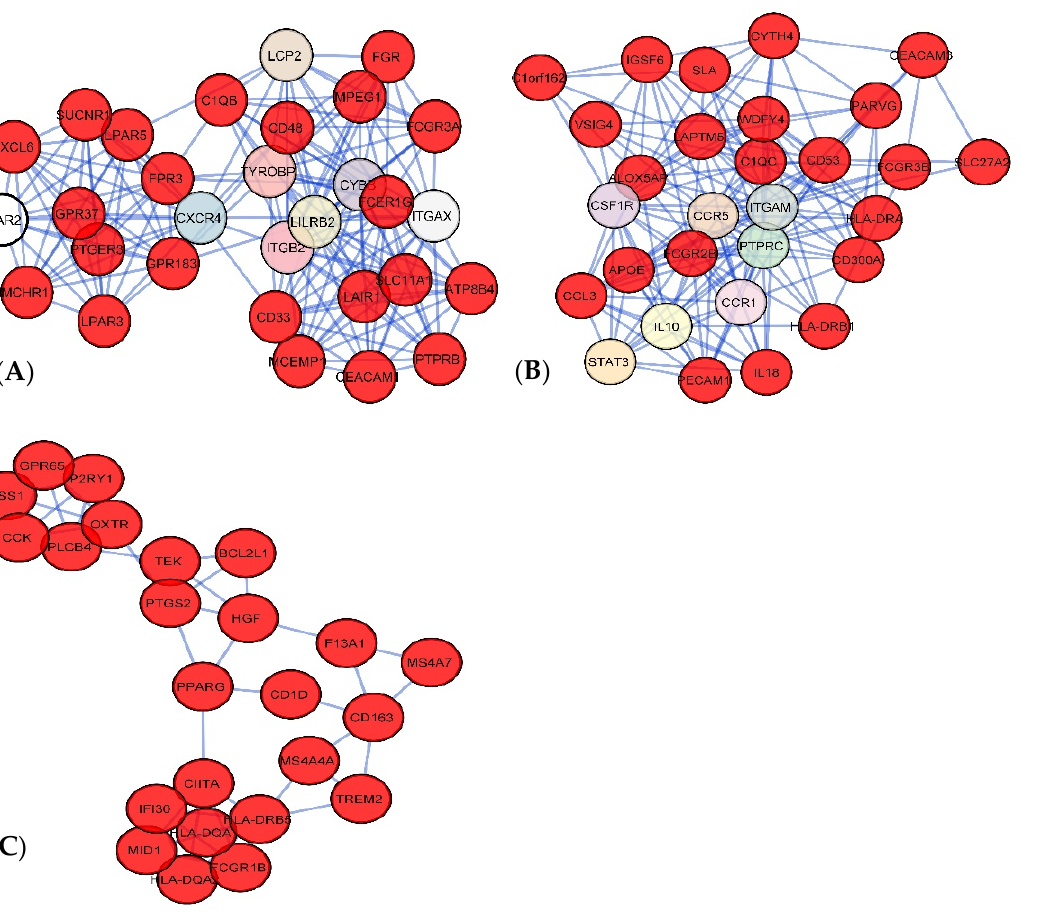
Figure 6. Module analysis of PPI network. ( A ) Module 1 had 30 nodes with 187 edges. ( B ) Module 2 had 29 nodes and 166 edges. ( C ) Module 3 had 24 nodes and having 57 edges. Table 2. Topological parameters for the twelve potential hub genes of the PPI